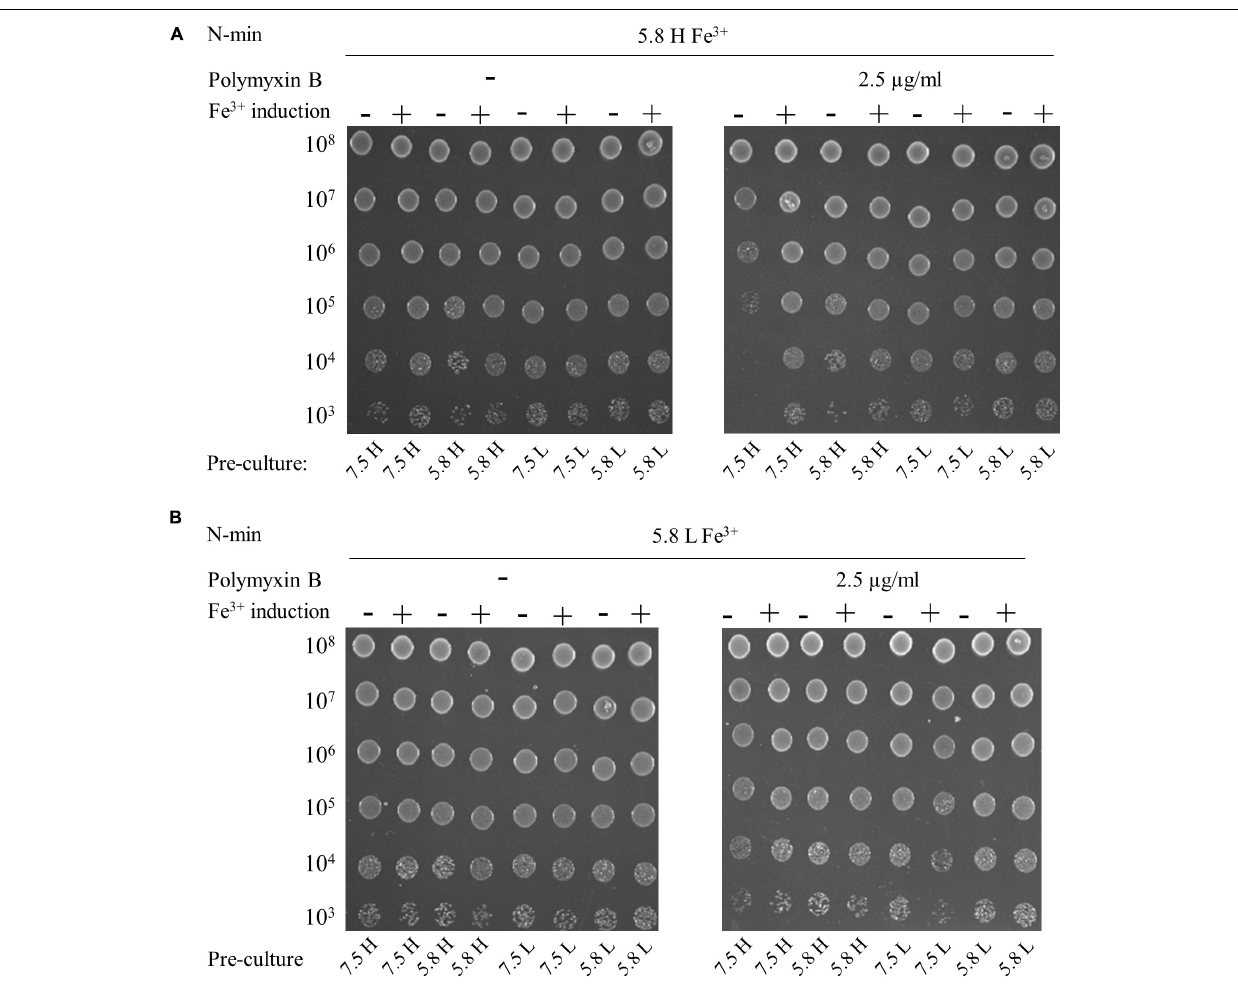
FIGURE 3 | Multiple signals are required to elicit polymyxin B resistance. W3110 strain was grown overnight in N-min at pH 7.5 or 5.8, with 1 mM (H) or 10 µ M (L) MgCl 2 . Cells were diluted (1:50) and incubated for 4 h at 37 ◦ C in the same medium (–) or in a Fe 3 + induction medium (+) that is N-min 5.8, high Mg 2 + and 300 µ M Fe 3 + . 5- µ l spots of appropriate dilutions of the suspensions were then deposited on plates supplemented or not with 2.5 µ g/ml of polymyxin B, as follows: (A) N-min at pH 5.8, high Mg 2 + and 300 µ M Fe 3 + (5.8 H Fe 3 + ). (B) N-min at pH 5.8, low Mg 2 + and 300 µ M Fe 3 + (5.8 L Fe 3 + ). The data are representative of at least three independent